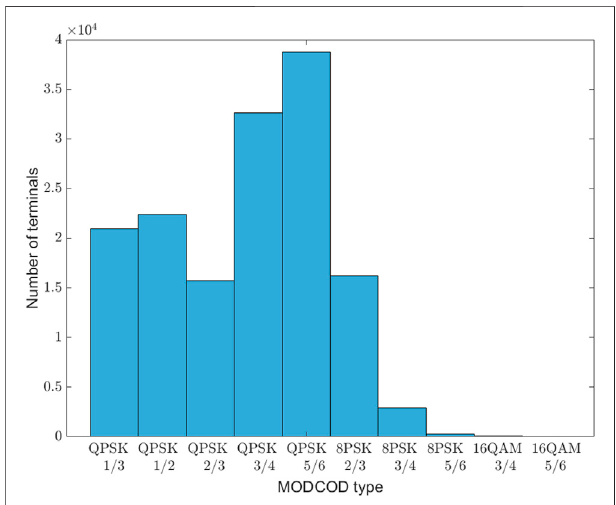
FIGURE 6 | Histogram of user terminal repartition among